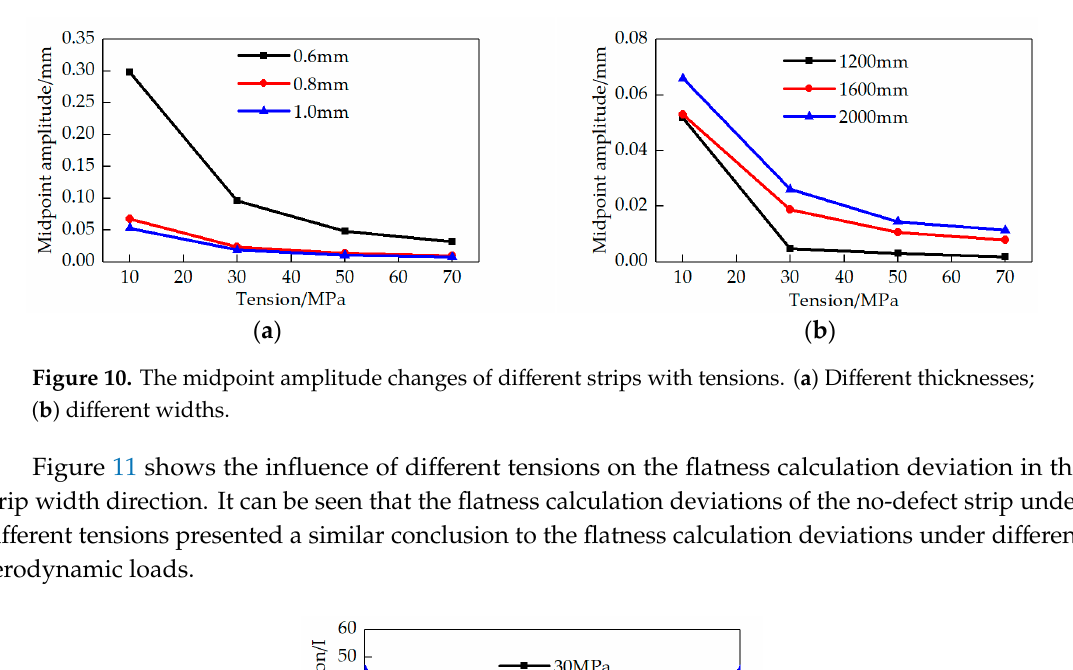
Figure 12. Metals 2019 , 9 , x FOR PEER REVIEW